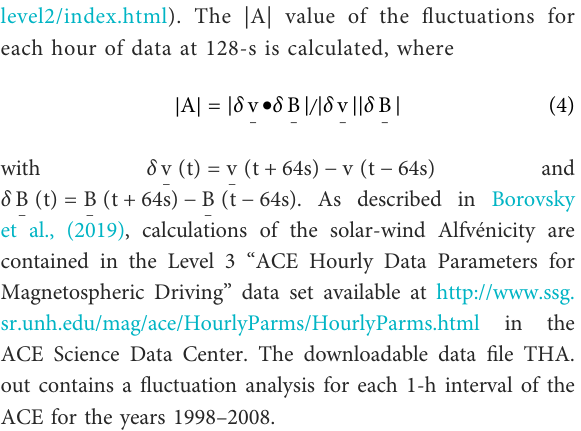
A| < 0.75. As can be discerned by the distribution shapes of Figure 6, the Alfvenicity tends to be high ( > 75%) or modest ( < 75%). The Alfvenicity is rarely unity. The fl at-shaped distribution of Alfvenicity values in Figure 6 (which should extend from |A| = 0 to |A| = 1) is consistent with uncorrelated (random, non-Alfvenic) values of δ B and δ v changes, i.e., non-Alfvenic regions of solar wind [ cf. Figure 11B of Borovsky et al., (2019)]. In the two panels of Figure 7 the relation of Alfvénic wind (red curves) versus non-Alfvénic wind (blue curves) to geomagnetic activity as measured by the AE index [panel (a)] and by the Kp index [panel (b)] is explored. Data for all